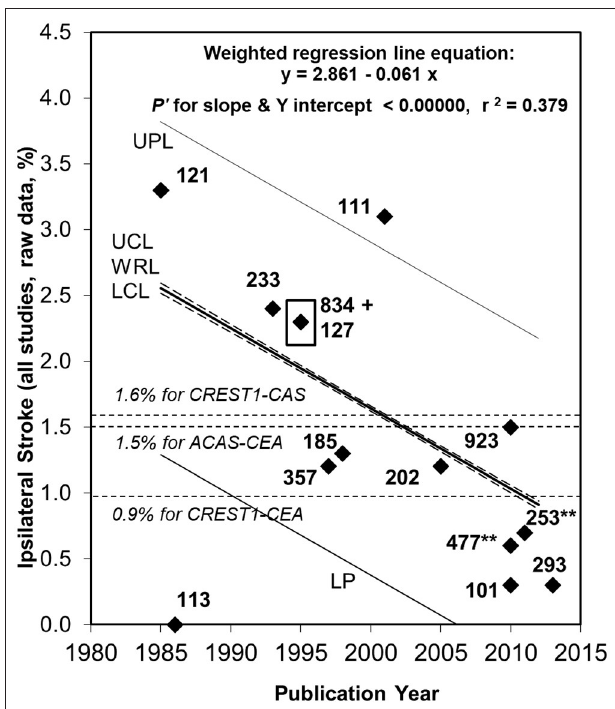
FIGURE 3 | Ongoing fall in ipsilateral stroke rate in patients with ≥ 50% asymptomatic carotid stenosis given medical intervention alone between 1984 and 2013 ( 2, 21). Sixty seven percentage relative (or 1.7% absolute) fall in the reported average annual ipsilateral stroke rate in patients with ≥ 50% ACS given medical intervention alone from 1984 to 2013. Fifty six percentage relative fall since ACAS was published in 1995 with 834 medically treated patients, ACAS result highlighted by a black box ( 35). Black diamonds are study results with corresponding sample sizes. As in 2009, the Ryan-Holm stepdown Bonferroni correction was made for multiple comparisons (converting raw P -values to P’ -values, SYSTAT 13, SYSTAT Software Inc) ( 21). UPL and LPL, respectively, = upper and lower 95% prediction limits for new population rate estimates; UCL and LCL (dashed lines), respectively = upper and lower 95% confidence limits for the population regression line; WRL, weighted regression line; ACAS, Asymptomatic Carotid Atherosclerosis Study ( 35); CREST-1, Carotid Revascularization Endarterectomy vs. Stenting Trial ( 65). **Indicates two studies including a small minority with remote ipsilateral stroke/TIA at baseline (94, 95). These were included in this analysis because the regression line was not appreciably different with (y = 2.861–0.061x, P’ for slope and y intercept < 0.00000 and r 2 = 0.379) (2) or without them (y = 2.720–0.051x, P’ for slope and y intercept < 0.00000 and r 2 = 0.275)